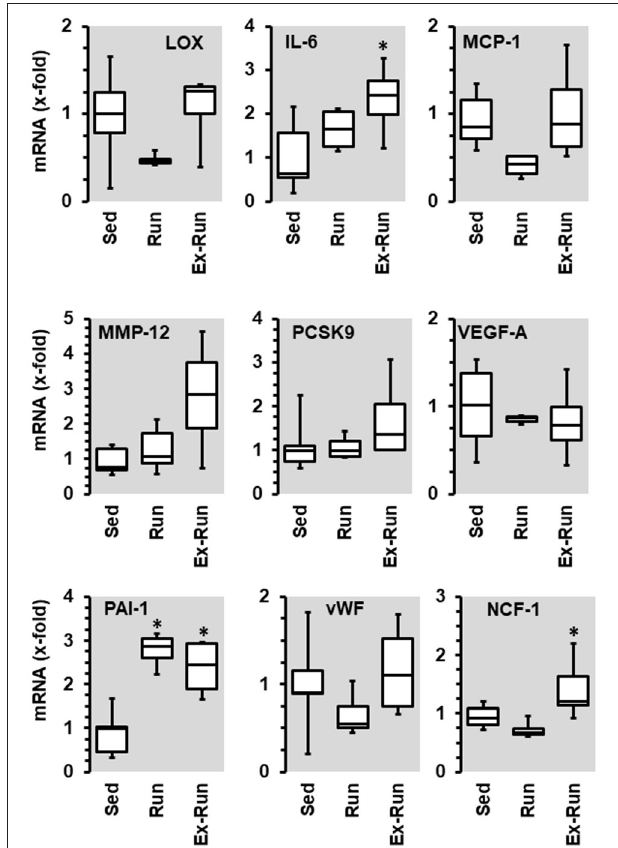
FIGURE 6 | Effect of 10 months voluntary running wheel activity (Run) on mRNA expression of selected proteins in hypertensive rats compared to sedentary controls (Sed) and SHRs running for 6 months with subsequent 4 rmonths cessation (Ex-Run). Box plots represent 25, 50, and 75 percentiles with 5 and 95 percentiles given as whiskers. * p < 0.05; One-Way ANOVA with subsequent Student-Newman-Keuls post-hoc